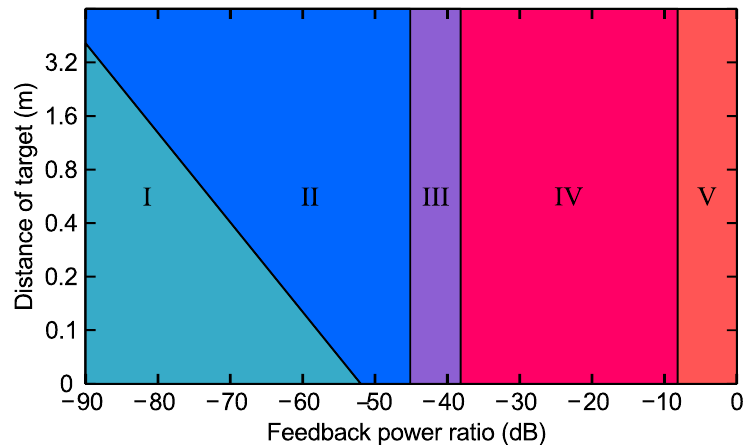
Figure 1. Five classical regimes of optical feedback in a typical laser